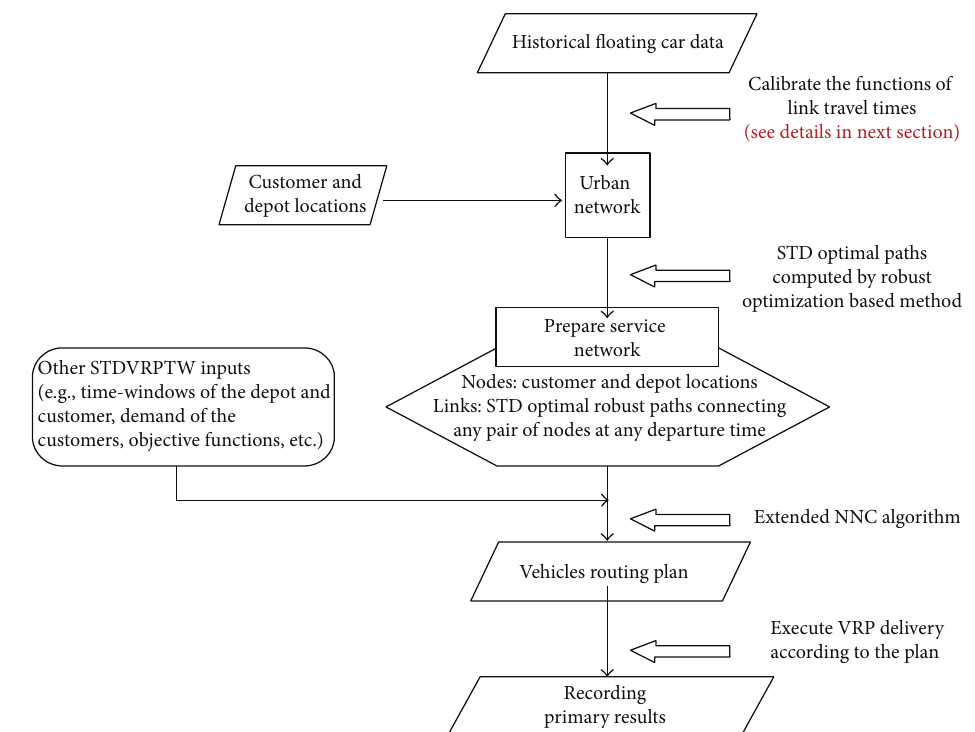
Figure 2: The illustrated solving procedure of STDVRPTW